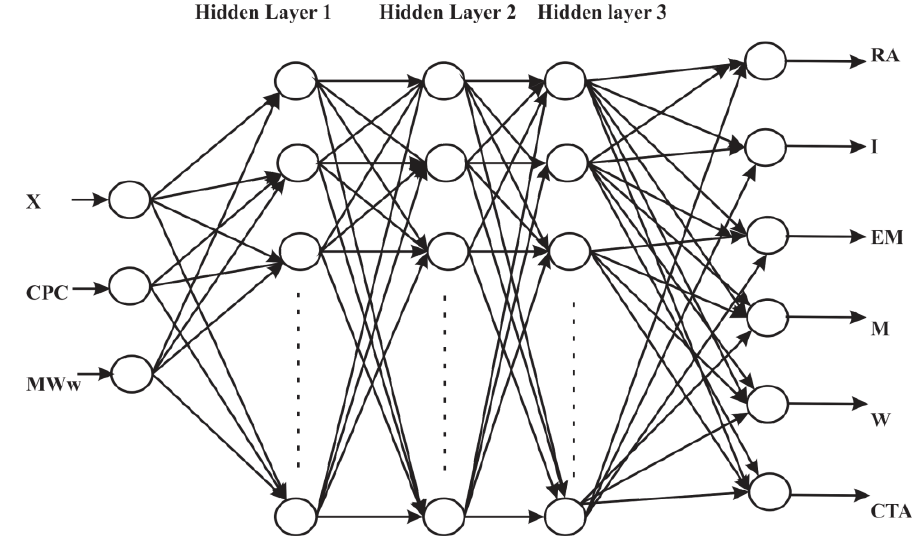
Figure 2. ANN structure used for inverse modeling with X , CPC, and MW w as inputs; RA, I, E, M, W, and CTA as outputs.